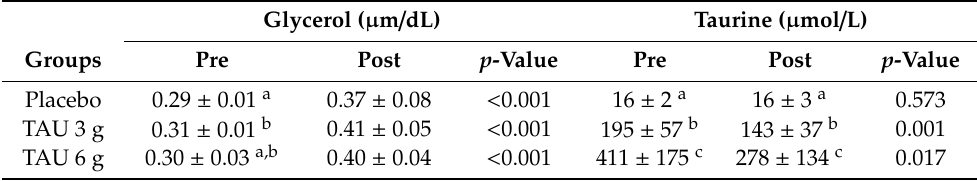
Table 2. Plasma taurine and glycerol concentration between evaluations.